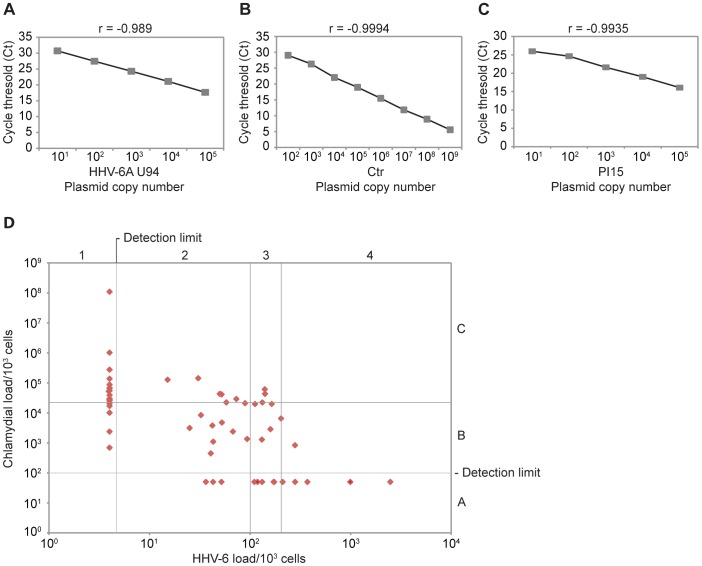
Quantitative real time PCR assay to detect HHV-6 and chlamydial load in cervical swabs and total blood samples.(A–C) Standard curves for HHV-6 and C. trachomatis quantification. Ten fold serial dilutions of U94 HHV-6A (A), C. trachomatis (B) and PI15 (C) plasmids were tested in triplicates in qPCR reaction. Mean Ct values were plotted against the copy numbers. Correlation coefficients and slope values are mentioned in each figure. (D) Scatter plot showing quantitative distribution of HHV-6 and C. trachomatis in cervical swabs of patients (n = 65) with suspected C. trachomatis infection as determined by real-time qPCR assay. Samples with no detectable HHV-6 and C. trachomatis are not included. Samples with HHV-6 DNA below detection limit (5 copies/103 cells) were arbitrarily specified as 4 copies/103 cells. Similarly, samples with less than 100 copies/103 cells were arbitrarily specified as 50 copies/103 cells. Sensitivity of PCR was marked as detection limits.